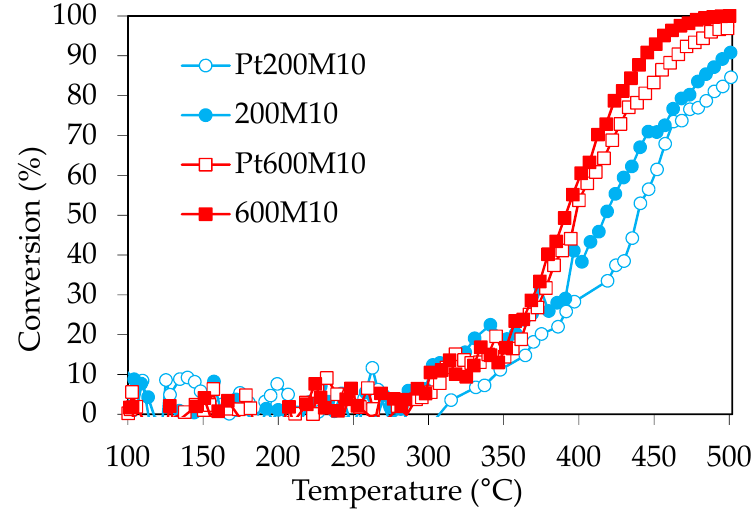
Figure 9. Comparison of DCM oxidation between 200M and M600 monoliths coated with AlSi10, with (open symbols) or without (closed symbols) Pt. 200M and 600M are meaning monoliths with 200 and 600 cpsi, respectively. The same experimental conditions were used as in Figure 6.